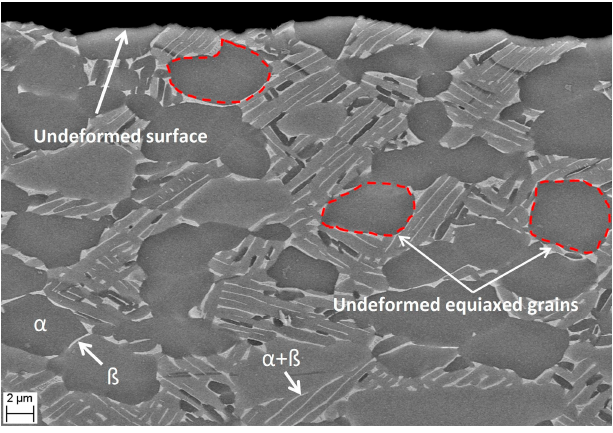
Figure 7. Typical microstructure of undeformed surface of Ti-6Al-4V (as-received material).